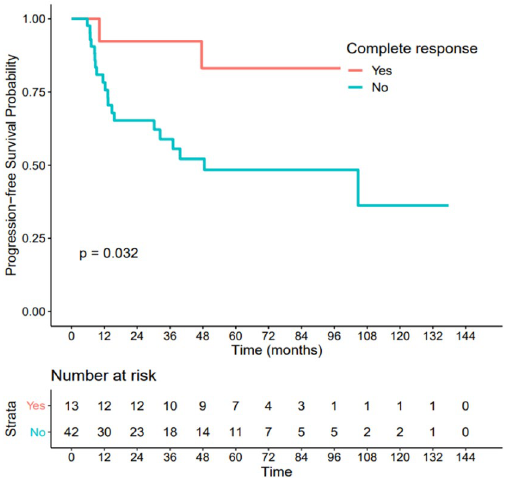
Figure 6. Association between pCR and disease-free survival. Patients with pCR had a significantly better disease-free survival (HR = 0.23 IC[0.05–1], p =